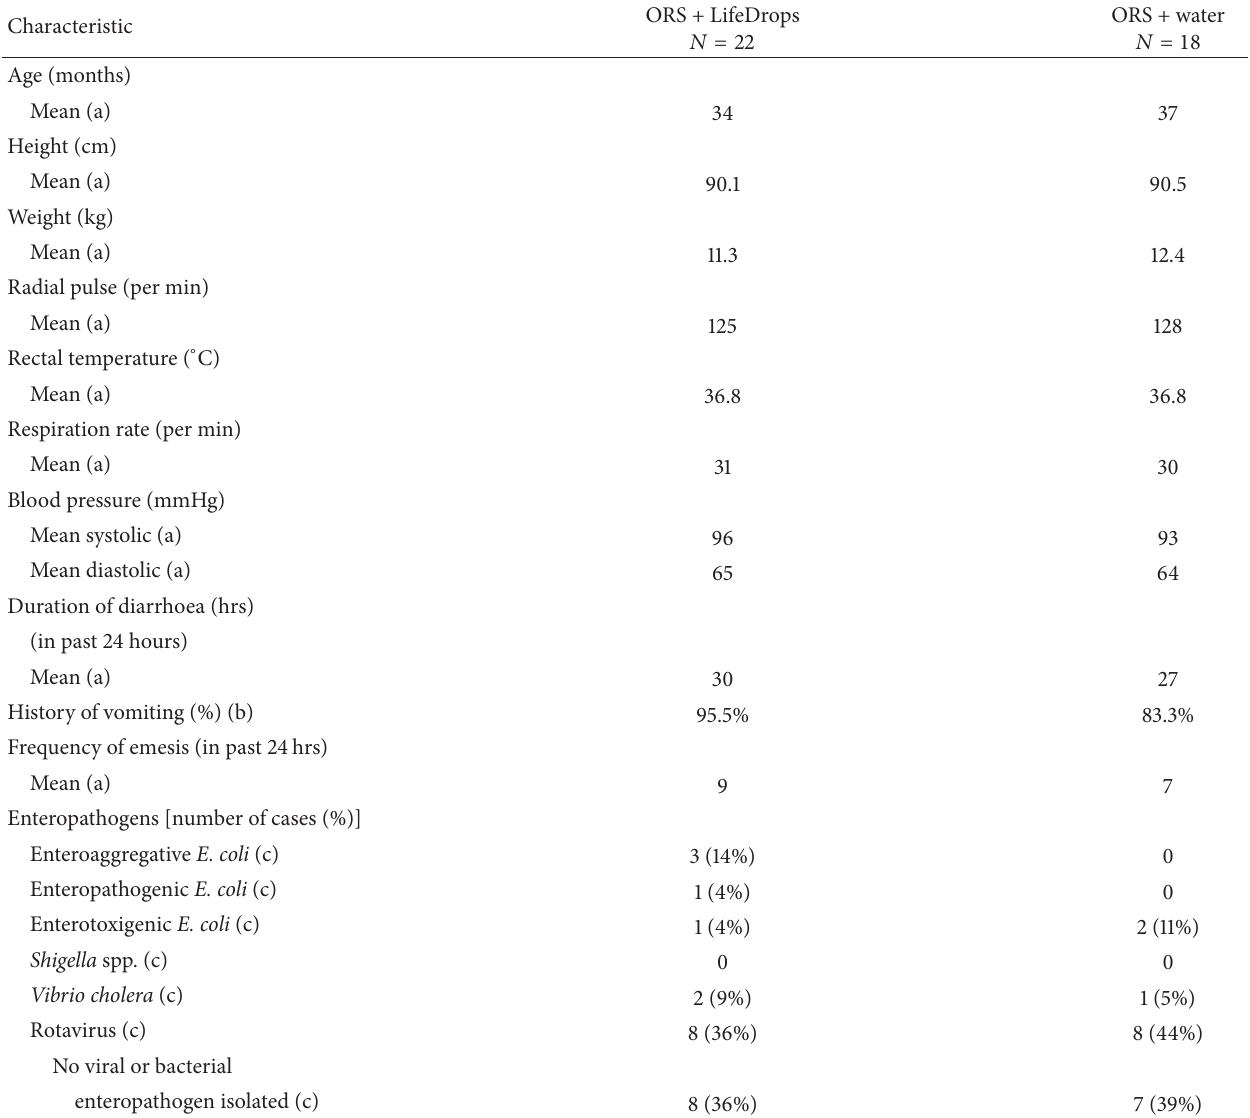
Table 3: Admission characteristics of subjects aged 2 to 5